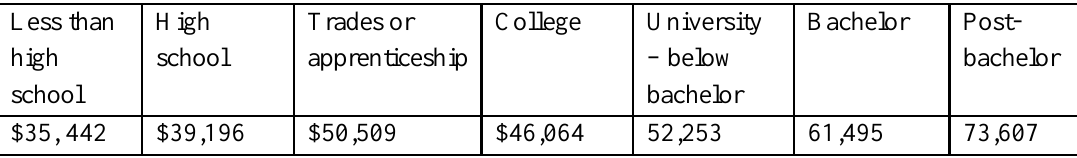
Median 2005 Earnings for Full-Year, Full-Time Earners by Education, Both Sexes, Total—Age group 25 to 64, for Canada, Provinces and Territories—Alberta Less than High Trades or College University Bachelor Post- high school apprenticeship – below bachelor school bachelor $35, 442 $39,196 $50,509 $46,064 52,253 61,495 73,607 Source: Statistics Canada (2010b,